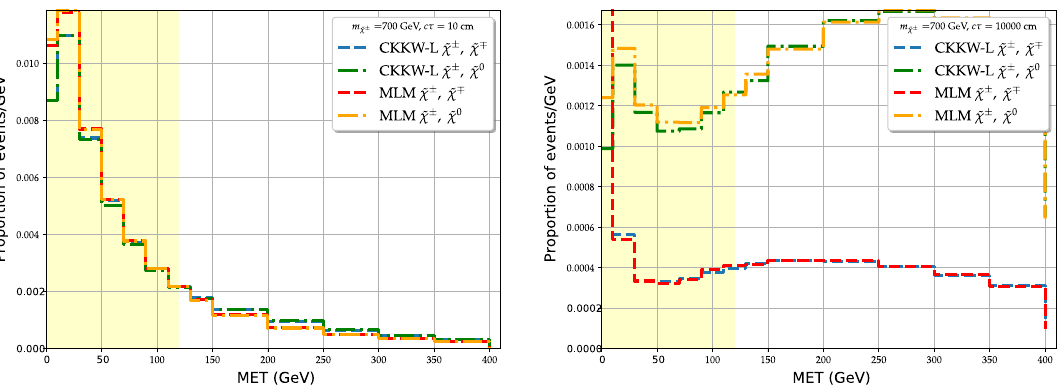
Fig. 2 Comparison of missing transverse energy distribution (propor- tion of events per GeV in each bin) for double-chargino and single- chargino events, for both CKKW-L merging and MLM matching. Left: 700 GeV winos with 10cm proper decay length; right: 700 GeV winos with 10,000cm proper decay length. On the right-hand figure, nearly